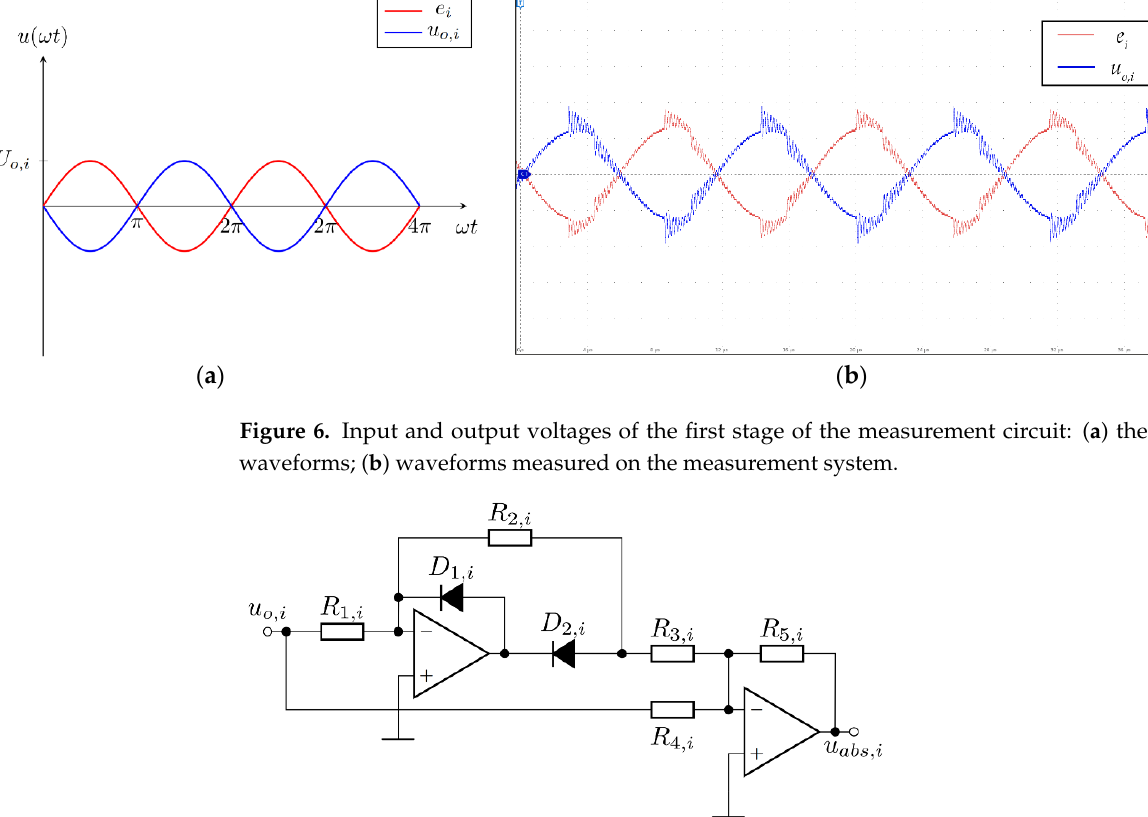
Figure 7. Measurement rectifier circuit.